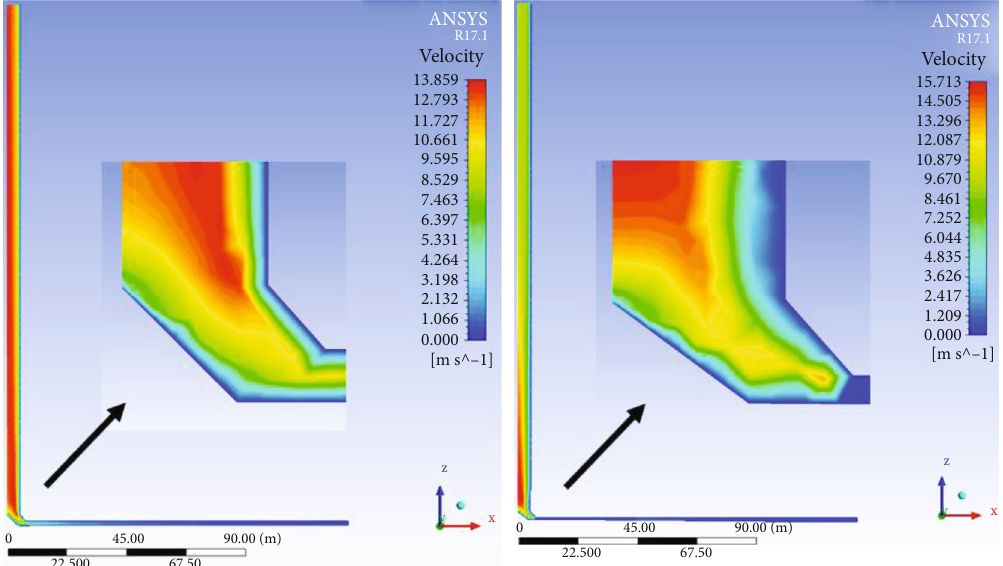
Figure 6: Velocity distributions in the pilot plant for horizontal (left) and sloping (0.5 ° ) ground